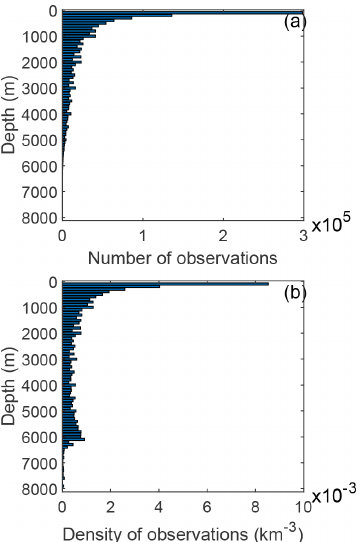
Figure 10. Number (a) and density (b) of observations in 100m depth layers. The latter was calculated by dividing the number of observations in each layer by its global volume calculated from ETOPO2 (National Geophysical Data Center/NESDIS/NOAA/U.S. Department of Commerce, 2006). For example, in the layer between 0 and 100m there are on average 0.0075 observations per cubic kilometer. One observation is one water sampling point and has data for several